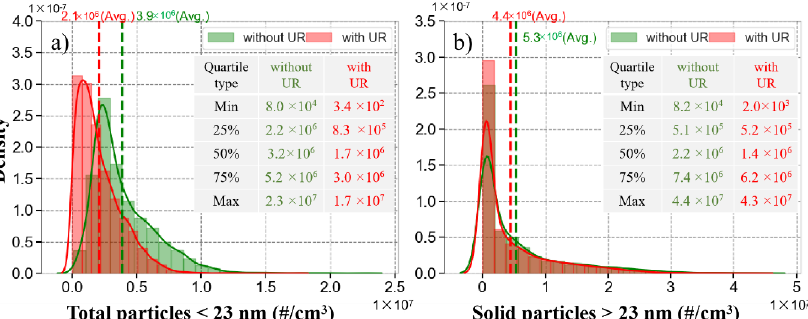
Figure 3. Comparison of the density distributions for total <23 nm ( a ) and solid >23 nm ( b ) PN volumetric concentrations with and without the illegal application of urea regulator.